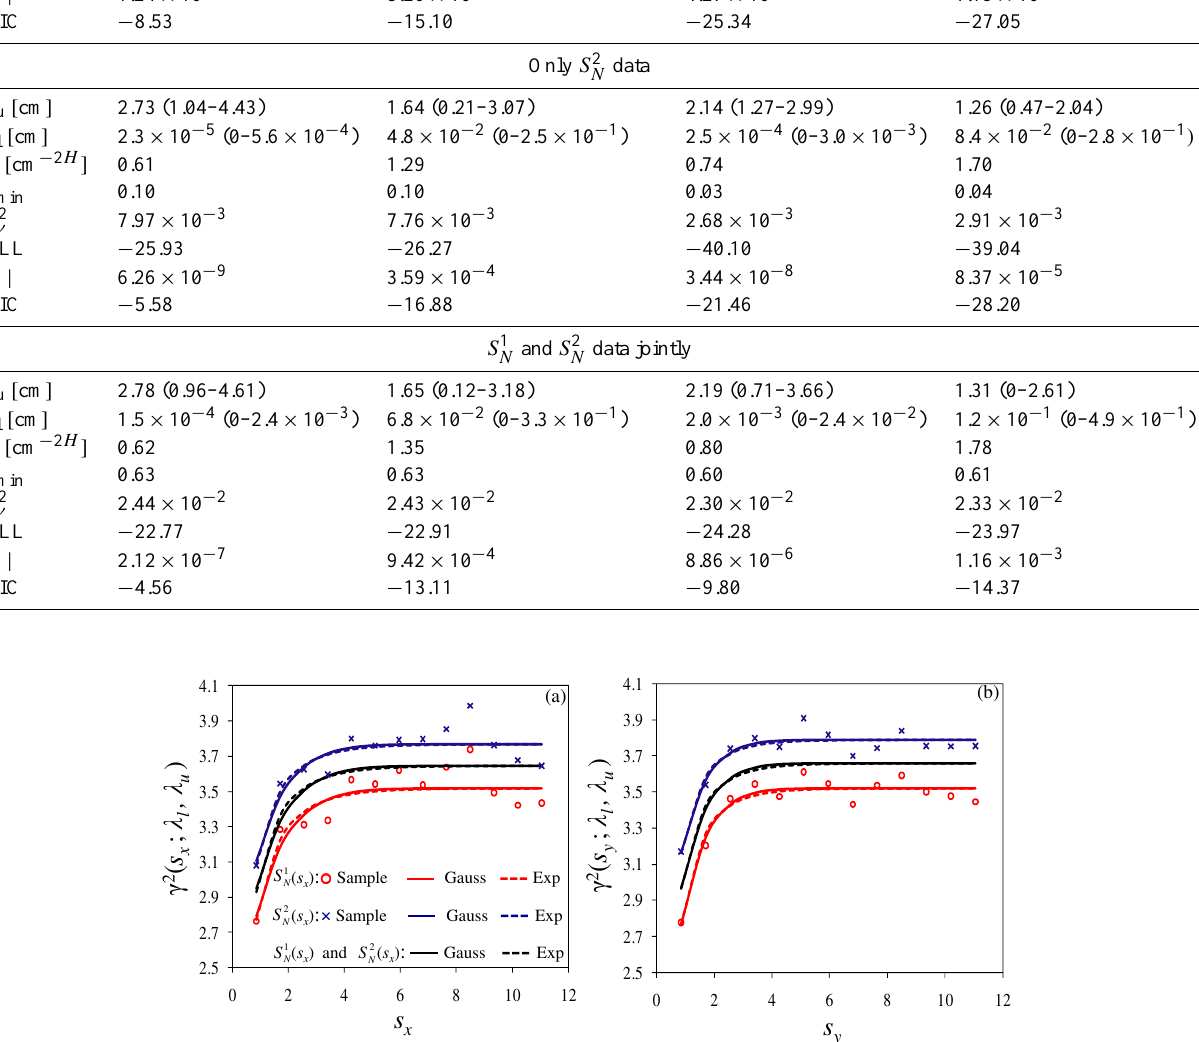
Fig. 14. Variograms obtained from multiple faces data in (a) x (faces 1, 2, 4) and (b) y (faces 1, 3, 5) directions, on the basis of S 1 and S 2 ( × ). Estimated variograms are also reported with continuous (Gaussian modes) and dashed (exponential modes) lines. Black lines N correspond to estimated variograms obtained on the basis of S 1